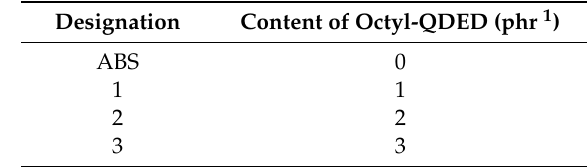
Table 1. Acrylonitrile butadiene styrene / octyl aminoethyl ammonium bromide (ABS / octyl-QDED) composites